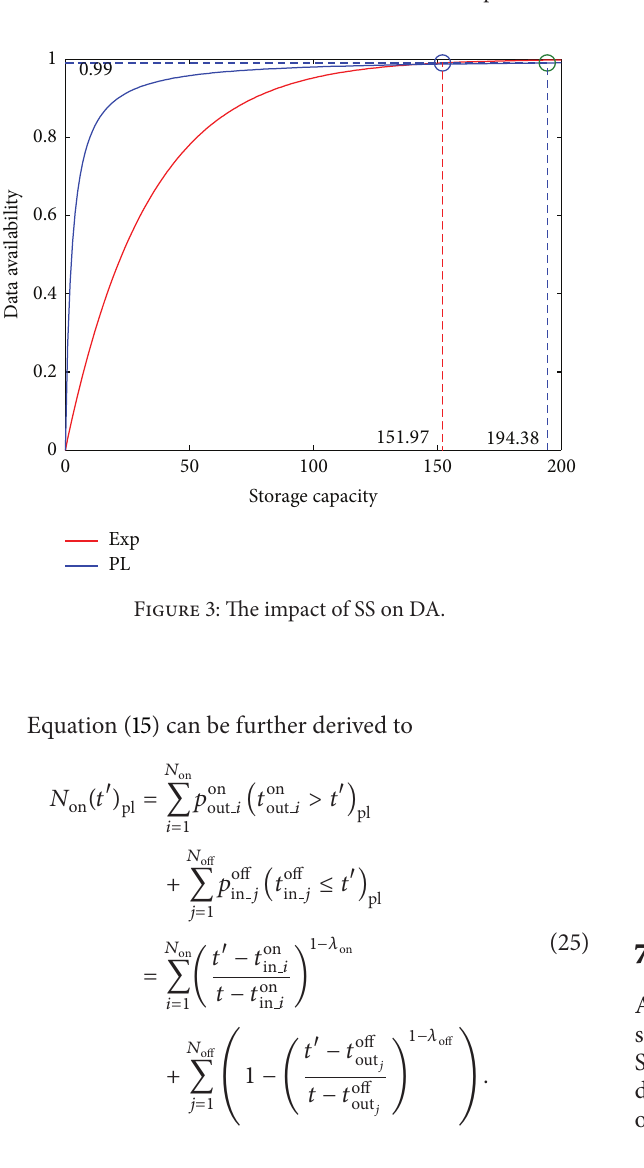
Figure 2: The states of all friends at current time point.